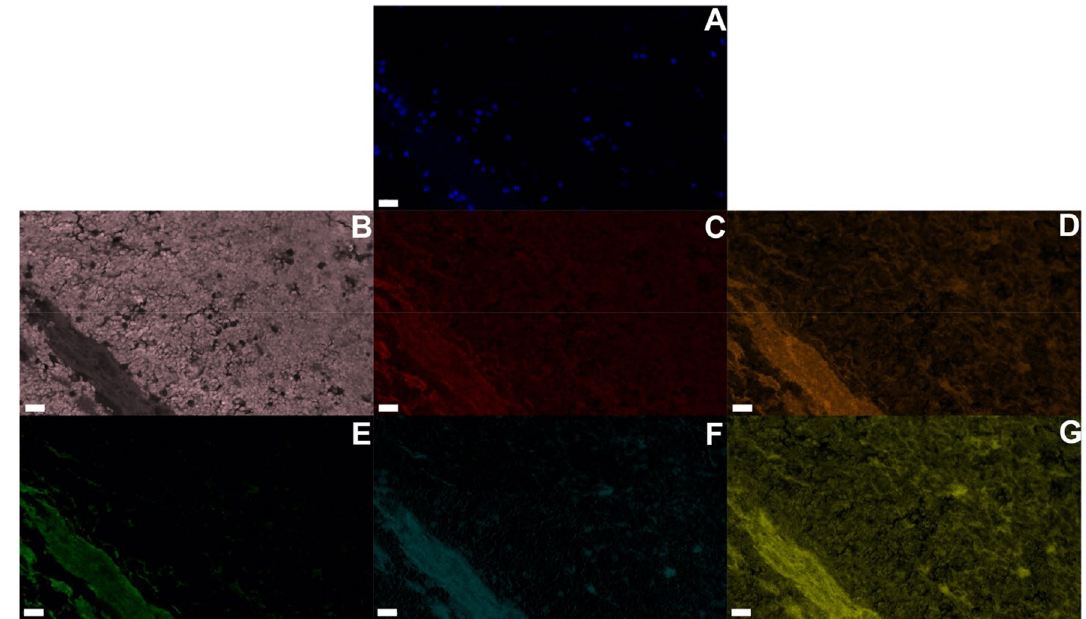
Figure 5. Representative multiplexed immunofluorescent images collected from VTE sample. ( A ) DAPI (nucleated cells) in blue, ( B ) erythrocytes (pink), ( C ) CD61 (platelets, red), ( D ) collagen, types i, ii, and iii (orange), ( E ) fibrin (green), ( F ) PAI-1 (cyan), and ( G ) VEGR-1 (yellow). The scale bar in the lower left corner corresponds to a 20 µm distance (40 × magnification). Antibody information can be found in Supplemental Table 2. A total of eight different antibodies were used for analysis, with five shown here. Autofluorescence was used to visualize erythrocytes. No cross reactivity was observed for antibodies as assessed with human tonsil control